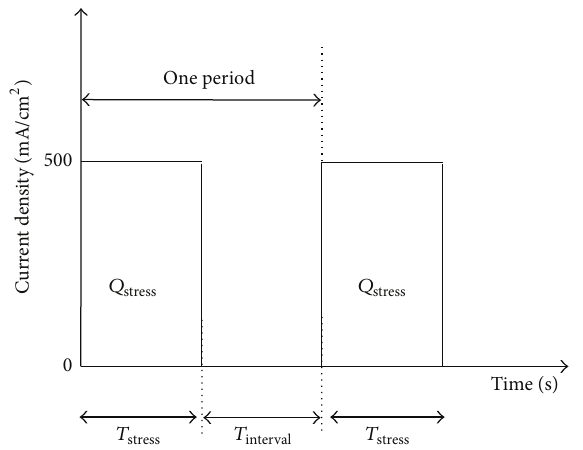
Figure 1: Experimental procedure of constant-current stress appli- cation. Every CCSconditionis500mA/cm 2 inallexperiments. 𝑄 stress is 6C/cm 2 or 12C/cm 2